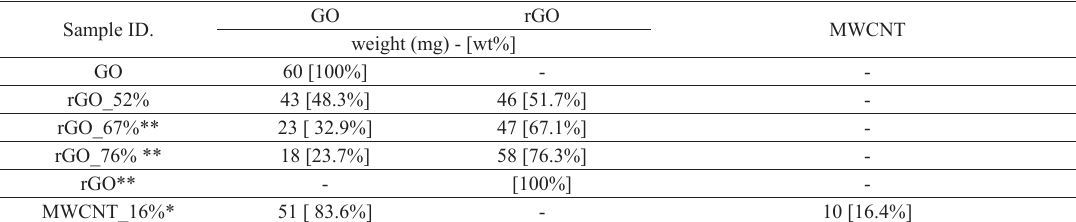
Table 1. Carbon materials mass concentrations applied at paper-like manufacturing samples. Sample